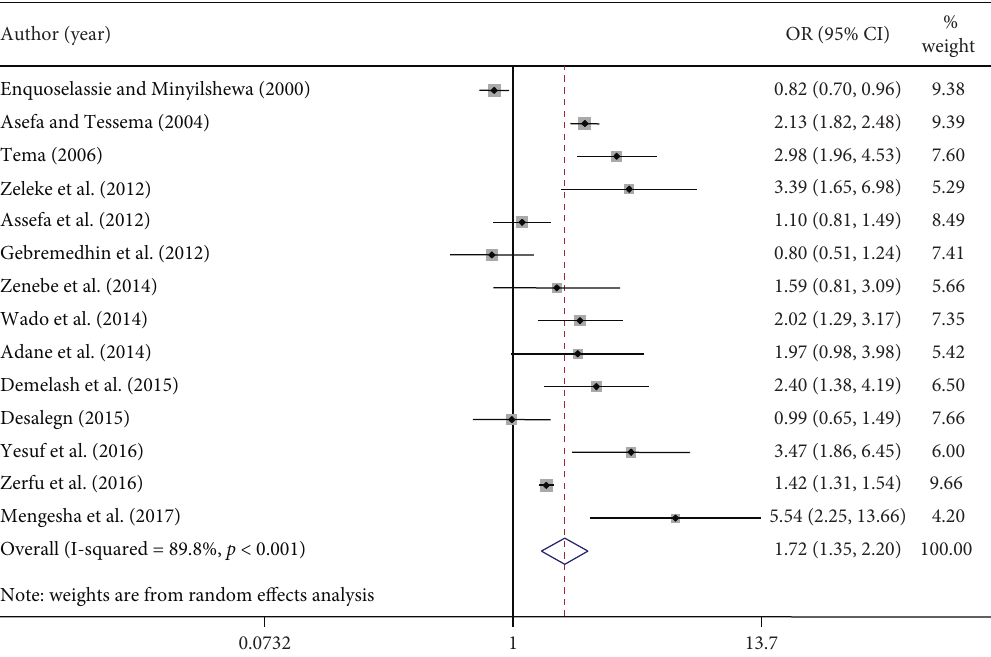
Figure 4: Forest plot displaying the association of absence of prenatal care and low birth weight of the newborn in Ethiopia.